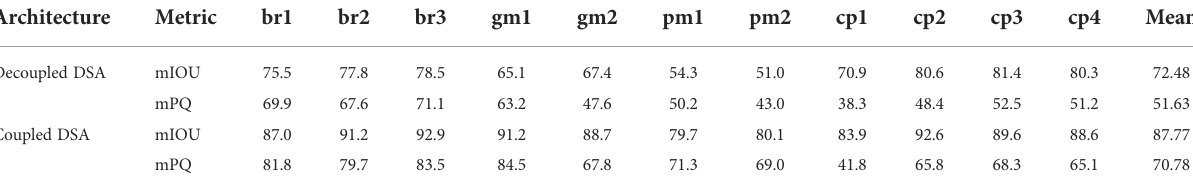
TABLE 7 Class-wise performance of coupled and decoupled DSA